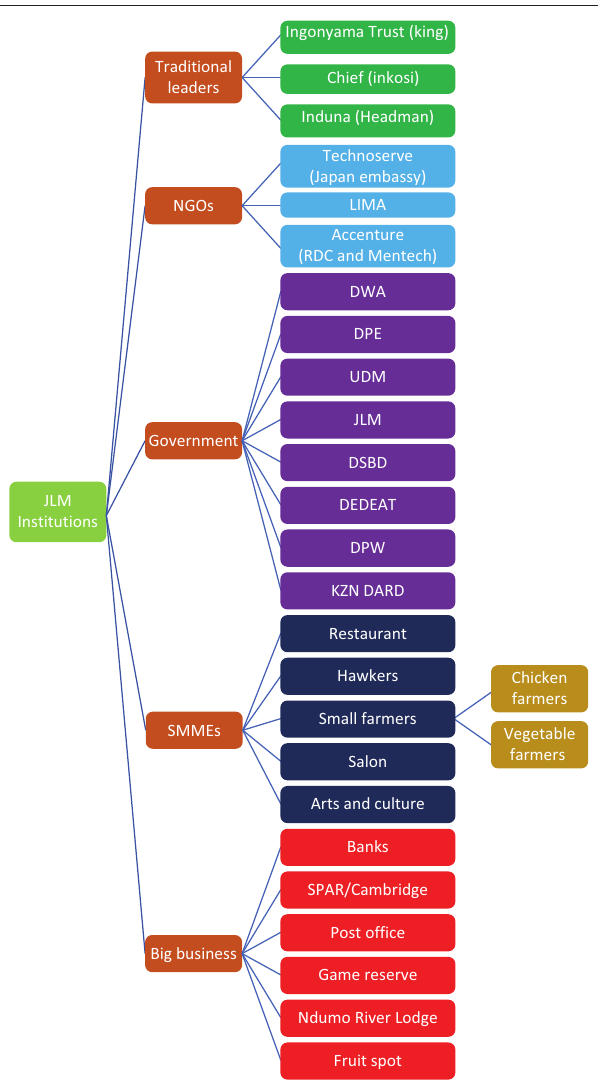
JLM, Jozini Local Municipality; LIMA, LIMA is a Non-Government Organization (NGO); DWA, Department of Water Affairs; DPE, Department of Public Enterprises; UDM, Umkhanyakude District Municipality; DSBD, Department of Small Business Development; DPW, Department of Public Works. FIGURE 2: Summary of Jozini Local Municipality’s small medium and micro enterprises social and institutional